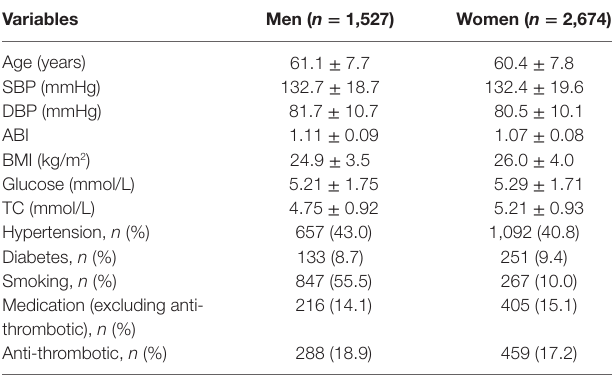
TaBle 1 | Baseline characteristics of study